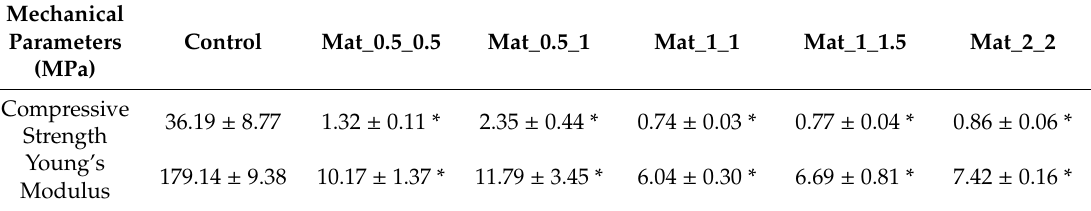
Table 3. Compressive strength and Young’s modulus values of the produced